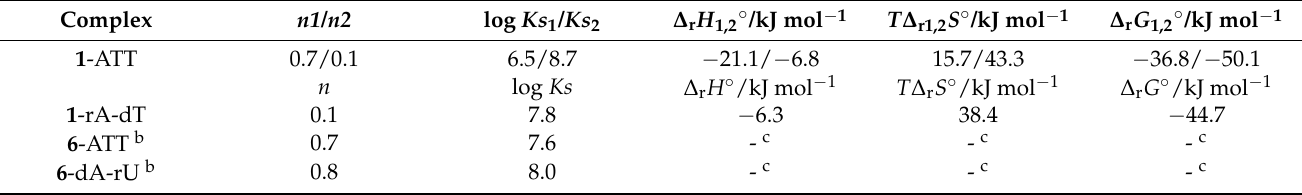
Table 2. Data parameters obtained during nonlinear regression (model: one and two sets of sites) for ITC titration for 1 -ATT, 1 -poly rA − poly dT complex. Binding constants (log Ks ) a and ratios n a ([bound compound]/[polynucleotide phosphate]) calculated from the fluorescence titrations for ligand-nucleic acid complex d